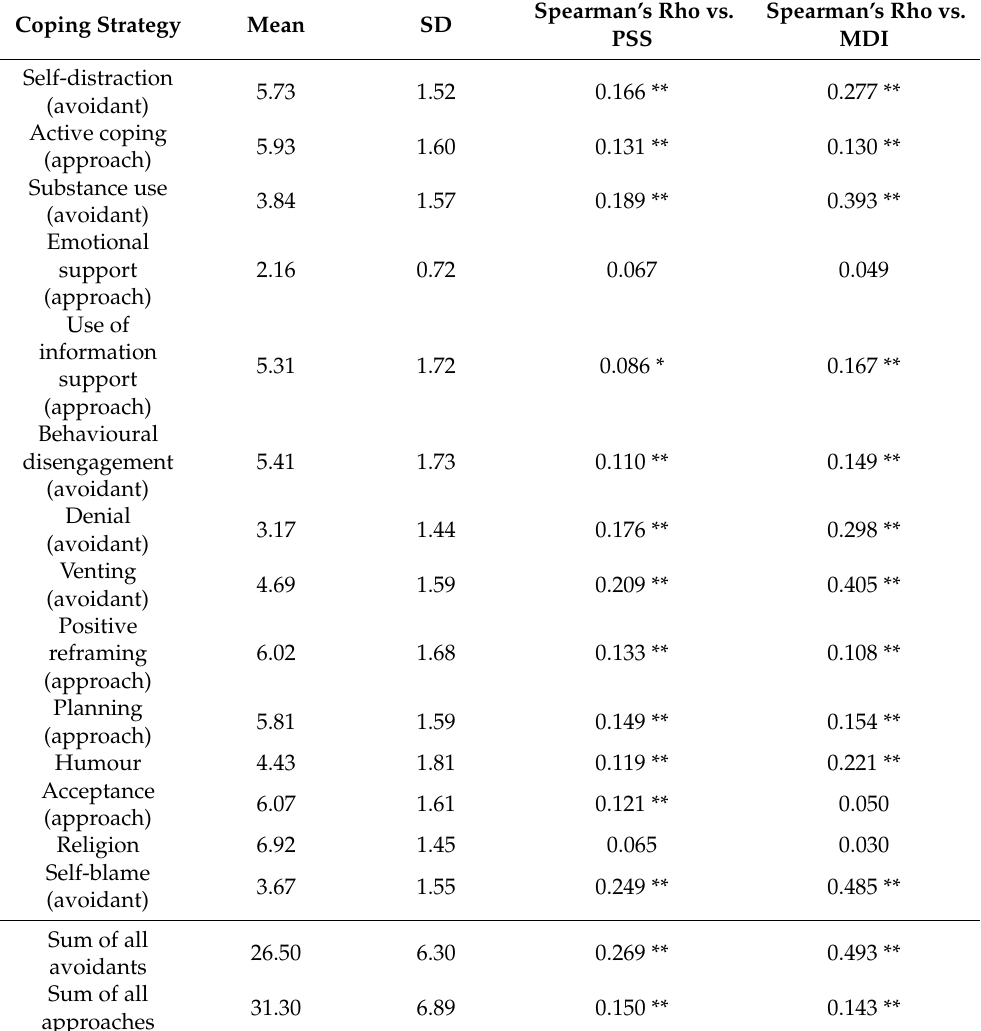
Table 4. COPE score of the participants and its correlation with Perceived Stress Scale (PSS) and Major Depression Inventory (MDI)